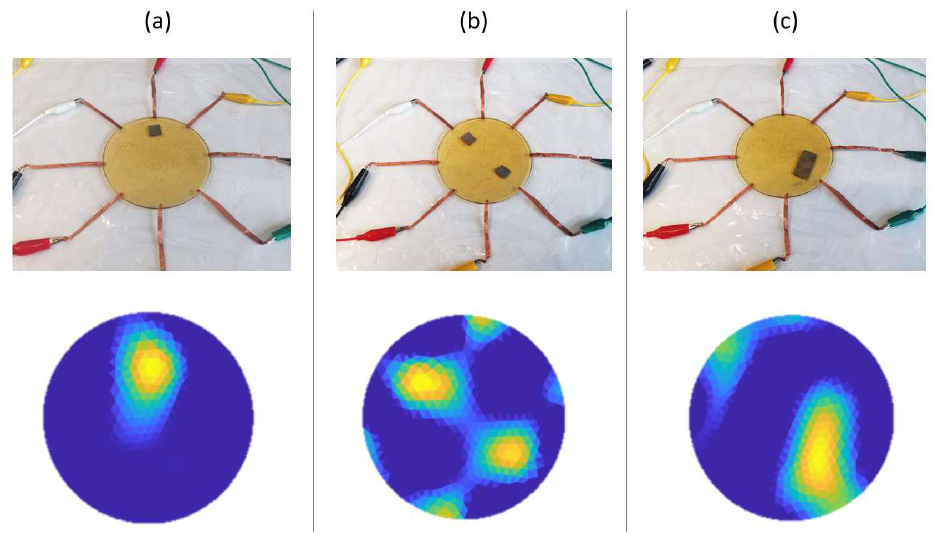
Figure 8. The proposed sensor is used to detect subtle contacts made by silver fiber fabric strips with negligible weight. ( a ) A single strip with a 1 cm 2 area is placed onto the sensor. ( b ) Two strips with the same 1 cm 2 area are placed onto the sensor. ( c ) A strip with a 3 cm 2 area is placed onto the sensor.